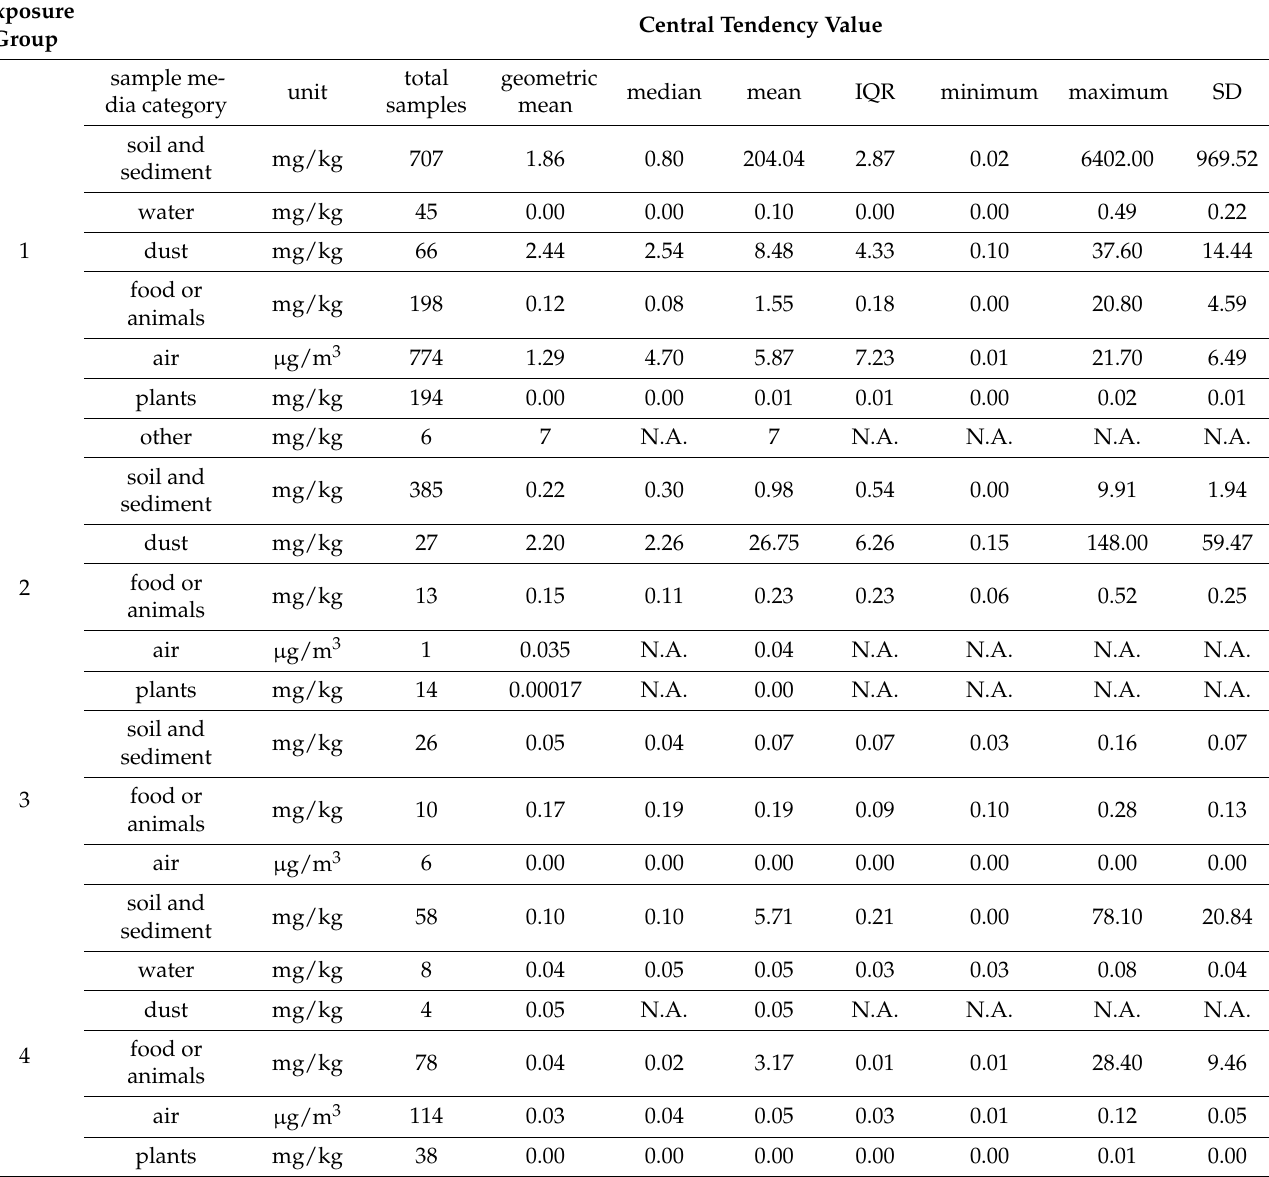
Table 3. Central Tendency Mercury Values of Environmental Samples Collected near E-Waste